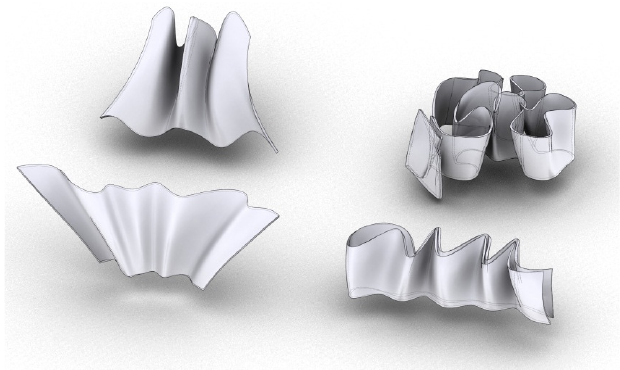
Figure 2. Objects based on mussel shell rim growth. ©Biornametics